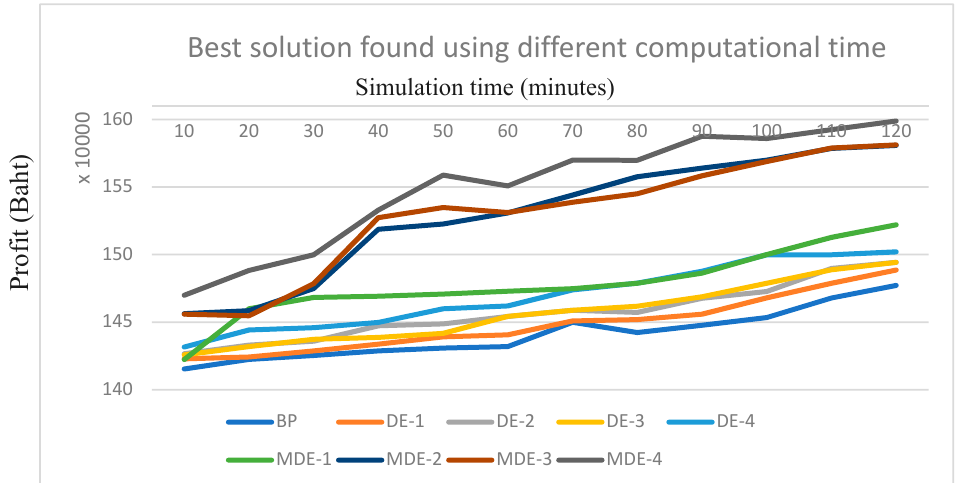
Figure 9. Best solution found using various computational time. Adm. Sci. 2019 , 9 , x FOR PEER REVIEW